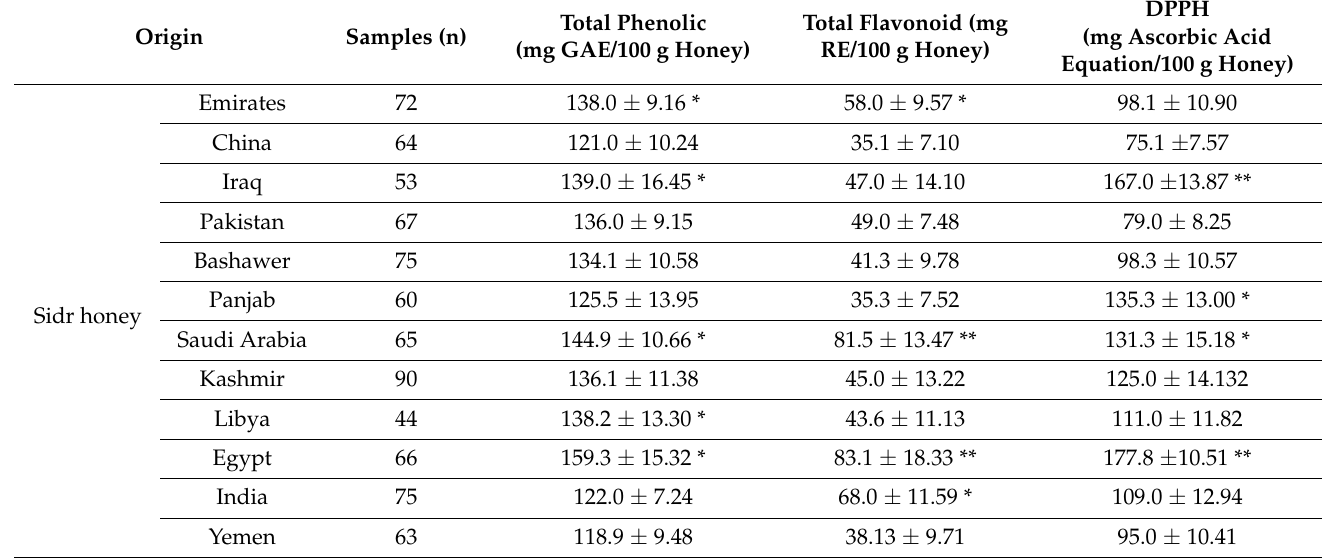
Table 5. TPC, TFC and DPPH of the Sidr